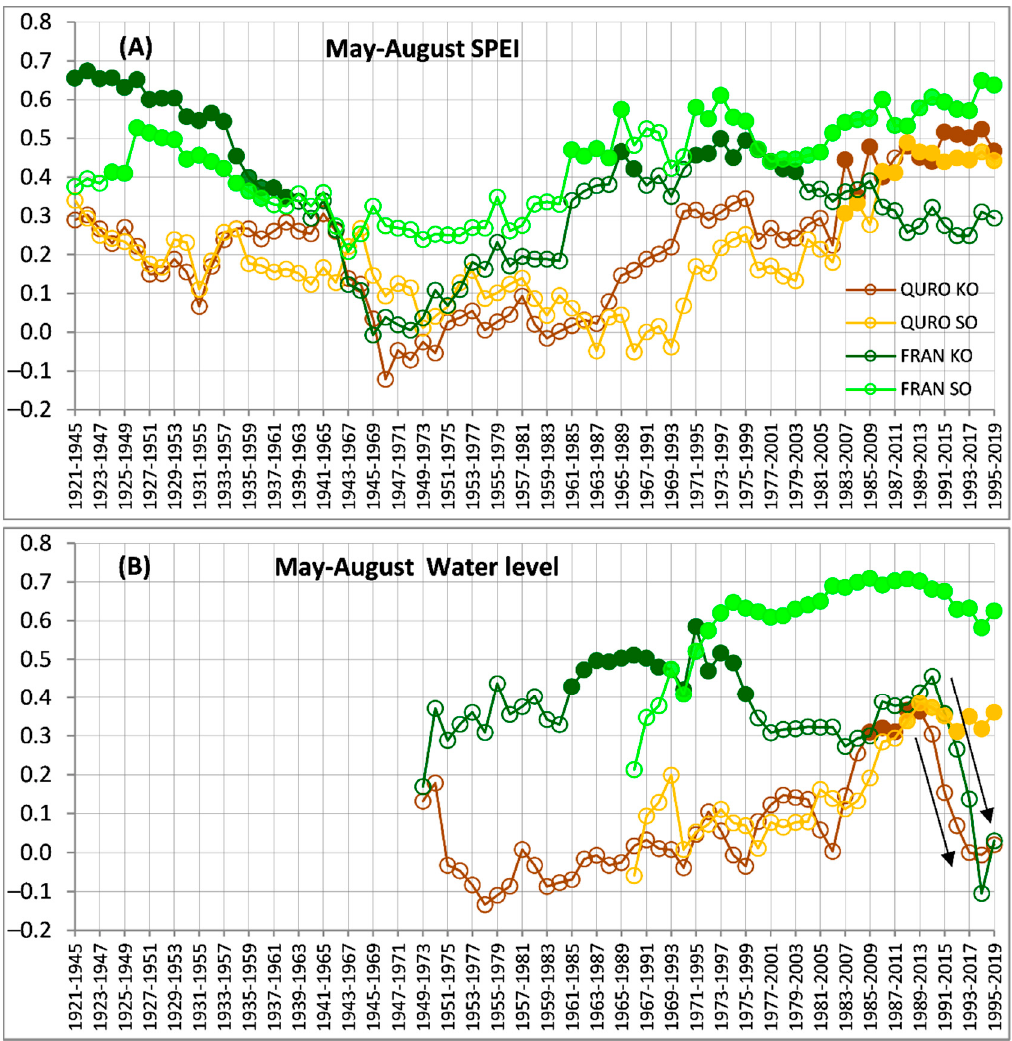
Figure 4. Moving correlations calculated between the tree ring width indices and selected monthly climate variables: ( A ) May–August standardized precipitation evapotranspiration index—SPEI, ( B ) May–August average water levels. The Pearson coefficients were calculated for 25-year moving windows lagged by 1 year for the 1920–2019 period. Filled symbols correspond to significant ( p < 0.05) correlation coefficients. The two arrows show the effect of revitalizations at the KO site. Species abbreviations: QURO— Quercus robur and FRAN —Fraxinus angustifolia ; site designations: KO and SO.